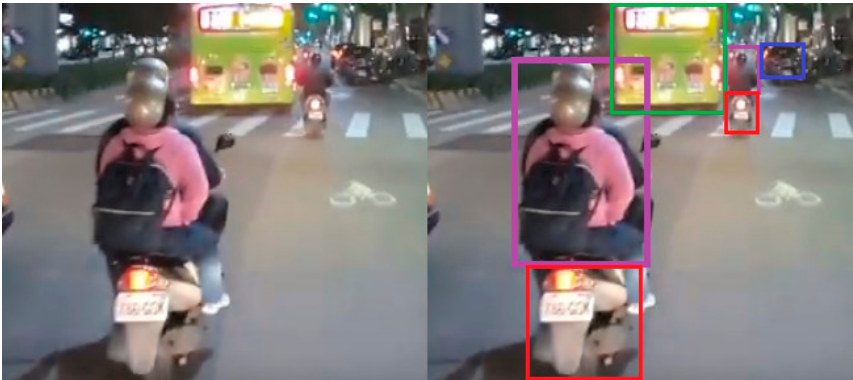
Figure 8. Occluded multiple objects with clearly visible outlines and noteworthy features. Upper : Part cropped from unlabeled data. Lower : Part cropped from labeled data.